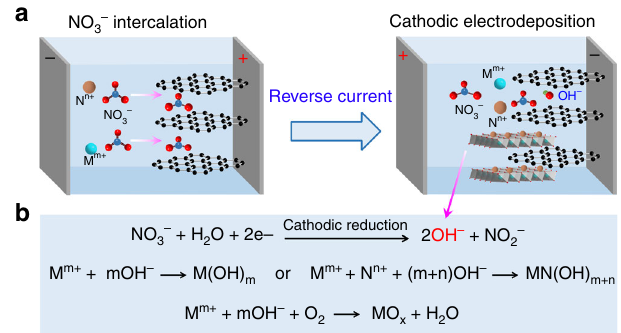
Fig. 1 Electrodeposition strategy and principles. a A schematic two-step synthesis using graphite (G) substrate and nitrate precursors. b The reaction mechanisms of the cathodic electrodeposition of metal hydroxides (M(OH) m or MN(OH) m + n ), and oxides (MO x ). M m + and N n + are